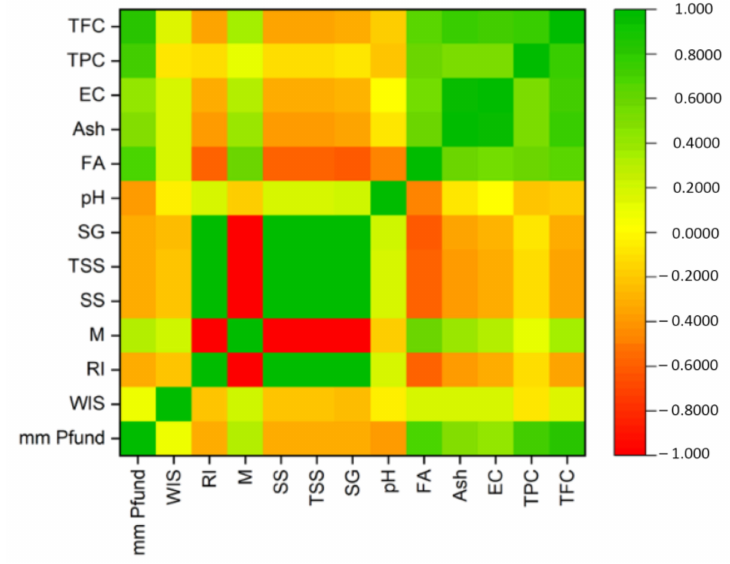
Figure 4. Pearson’s correlation coefficient results presented on a heatmap.